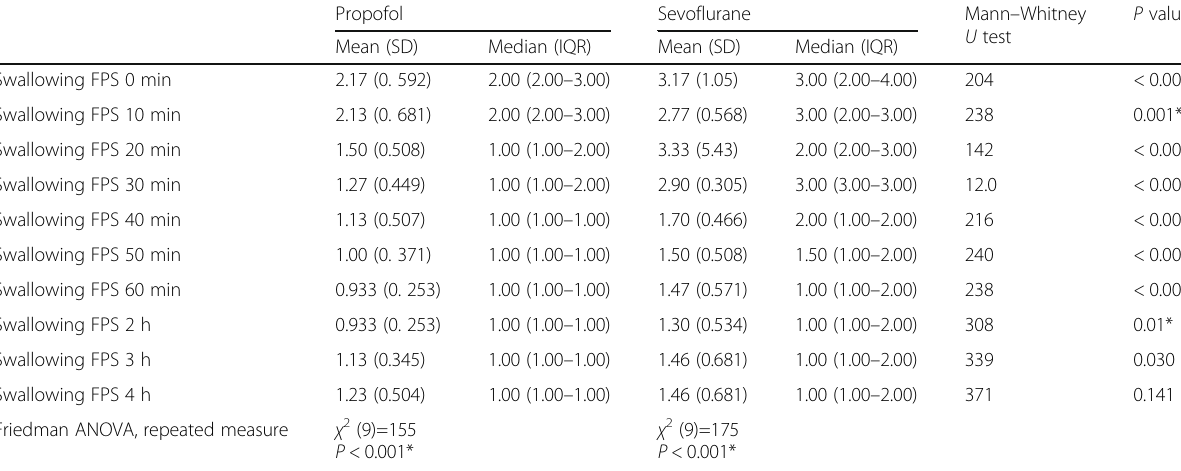
Table 4 Swallowing face pain score during the 4-h postoperative period Propofol Sevoflurane Mann – Whitney